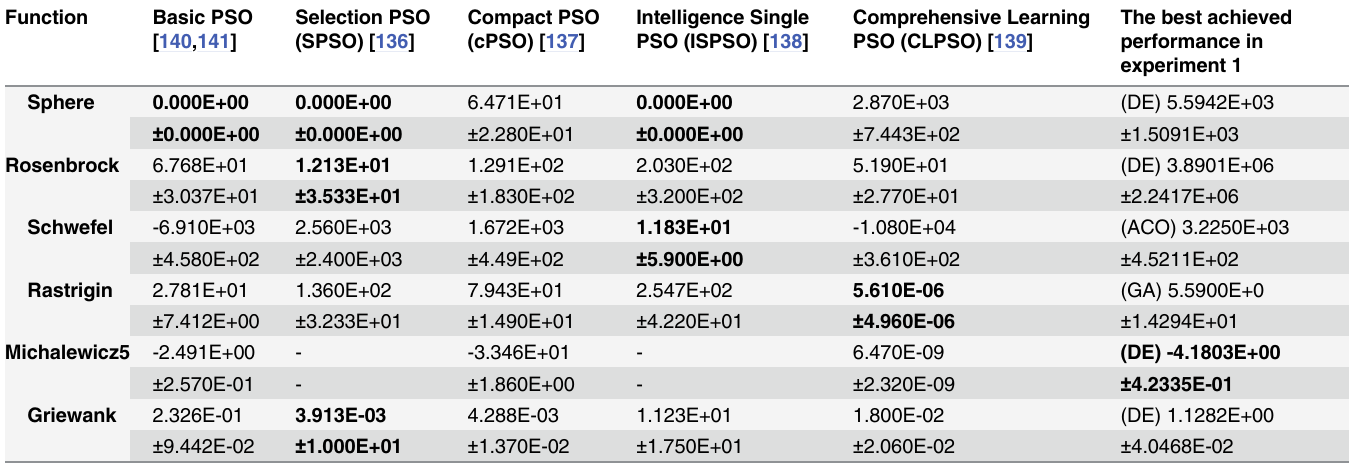
Table 11. Comparison between various PSO-based algorithms (Mean ± SD).